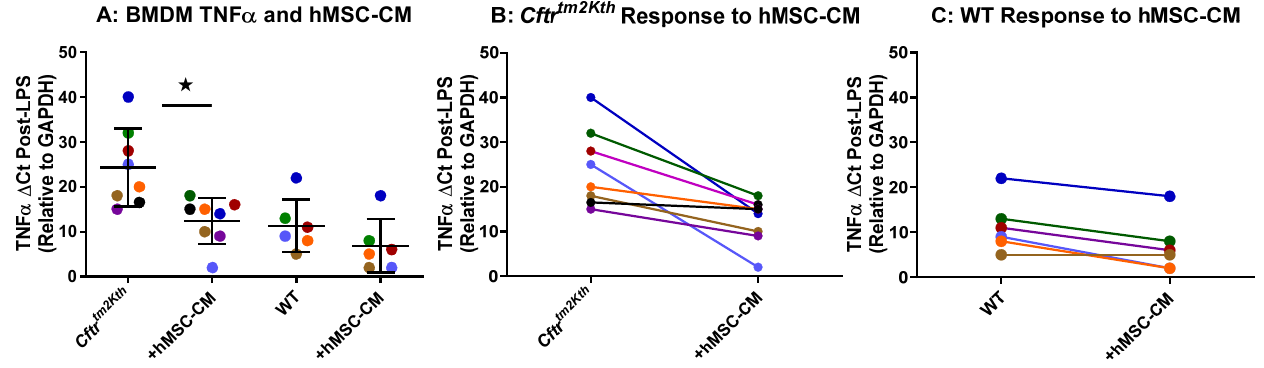
Figure 1. hMSC Anti-Inflammatory Potency Screen on Murine BMDM. Each of the pre-GMP donor preparations (shown by a different color) were cultured in the absence of antibiotics for 72 h. The supernatants were screened for the ability to suppress the production of TNF α from either murine WT or Cftr tm2Kth BMM stimulated with LPS (10 µg/mL, n = 8) ( A ). Evaluating each hMSC-CM individually, the Cftr- deficient ( B , n = 8) and WT ( C , n = 6) were analyzed. Consistent with previous studies, the hMSCs significantly decreased TNF α gene expression by the BMDM stimulated with LPS (star designates p < 0.05) with each hMSC-conditioned medium having a unique anti-inflam- matory potency.